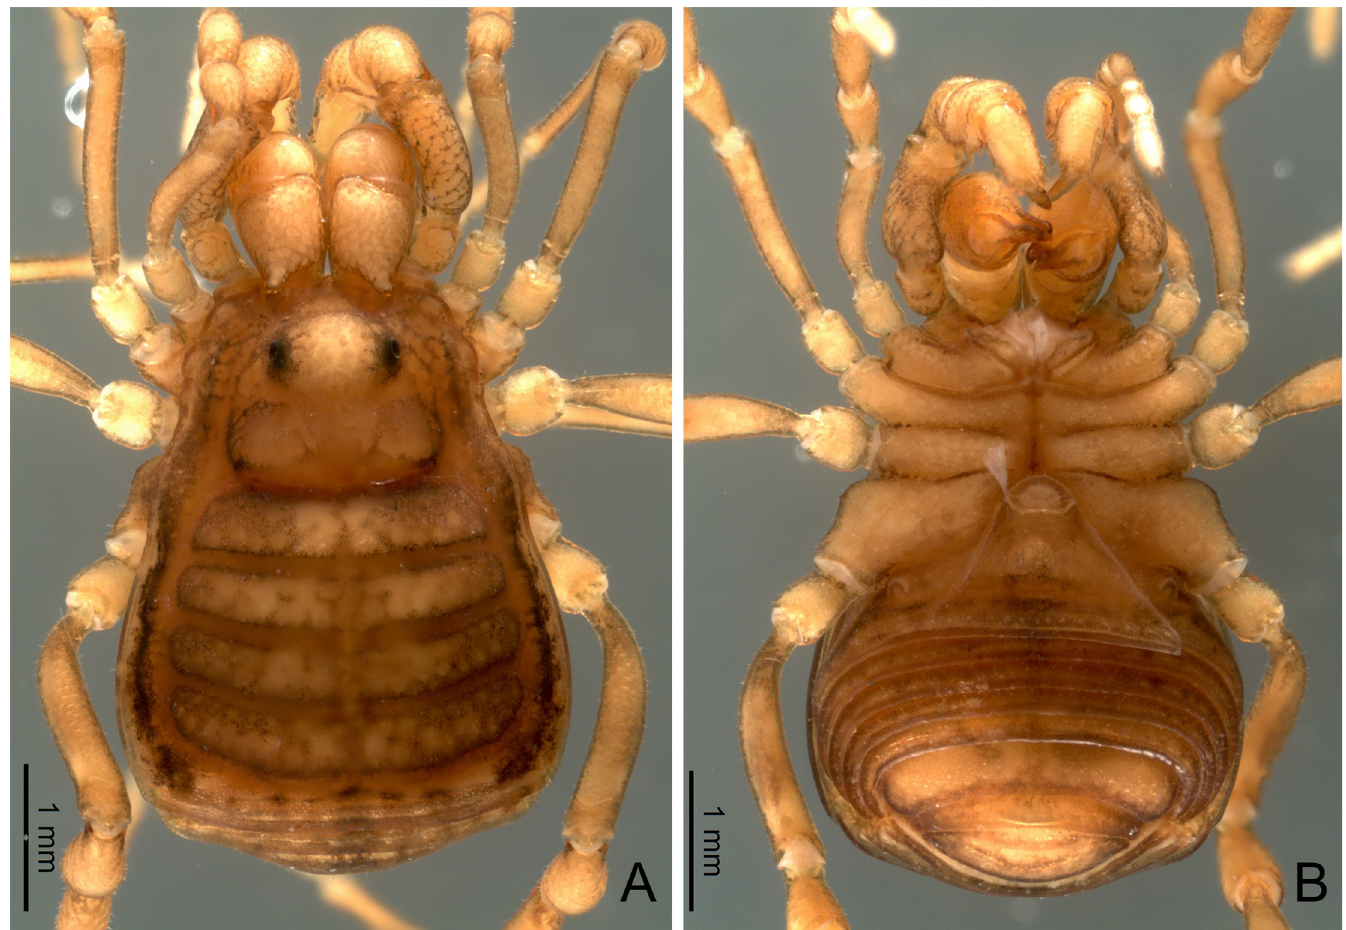
Fig 6. Osornogyndes tumifrons Maury, 1993, paratype male (MACN 9117), habitus. A. Dorsal view; B. Ventral view. Photos: Willians